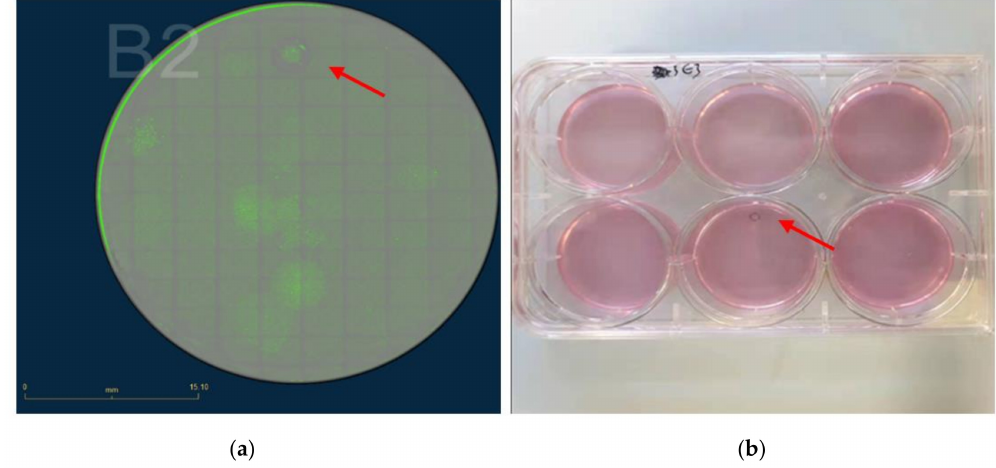
Figure 10. Image of marked monoclonal cells in 6-well plate. ( a ) Well B2 scanned by eGFP fluorescence, Scale bar = 15.1 mm. ( b ) Picture of 6-well plate with marked monoclonal cells. The interesting clone is marked by a red arrow.